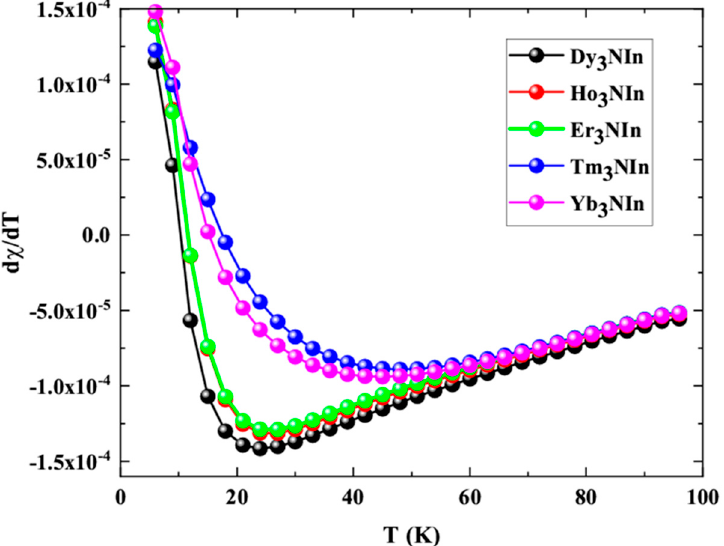
Figure 12. Derivative of magnetic susceptibility of the rare earth nitrides Ln 3 NIn (Ln = Dy-Lu)anti-Perovskite.